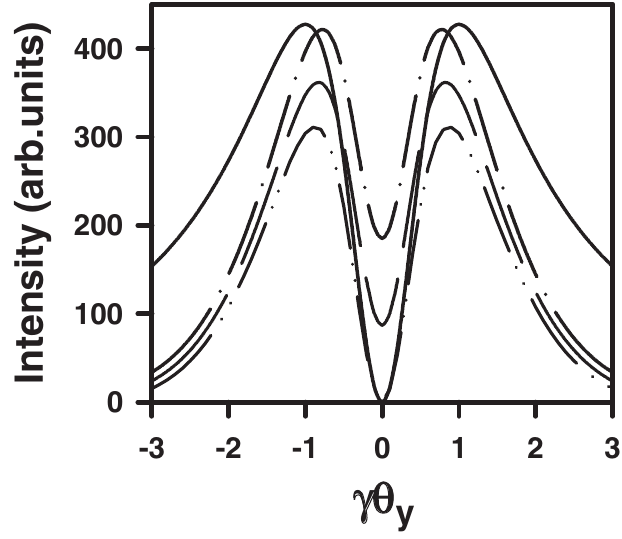
FIG. 3. TR (solid line) and DR angular distributions calculated for different electron positions with respect to the slit center: (cid:5) 0 , dash-dot-dotted line; a a s (cid:5) 90 (cid:8) m , dash-dotted line. Calculation parameters: (cid:1) (cid:5) a s 2500 , (cid:2) (cid:5) 500 nm , a